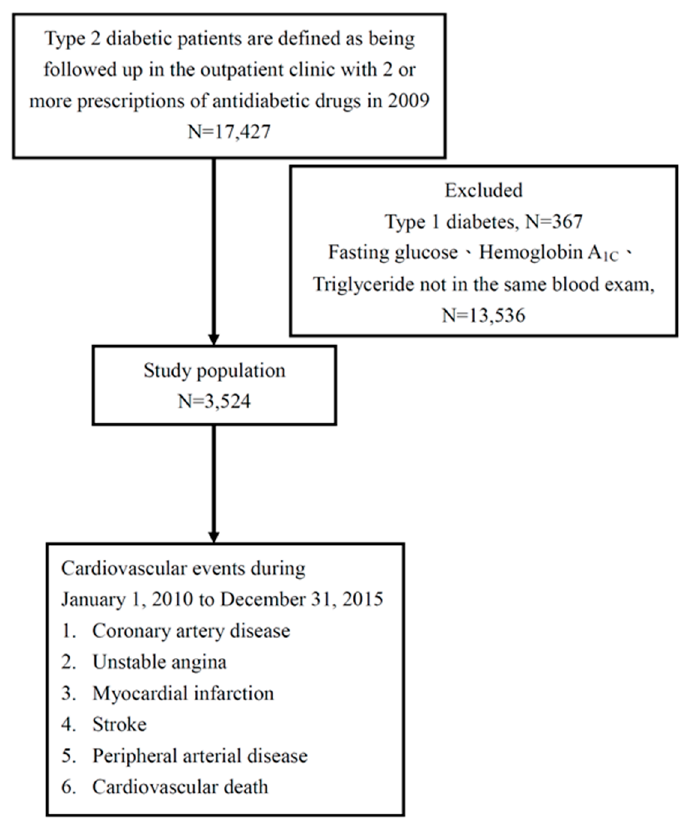
Figure 1. Flow chart of study participants for the evaluation of the effects of fasting glucose on cardiovascular events in type 2 diabetes.